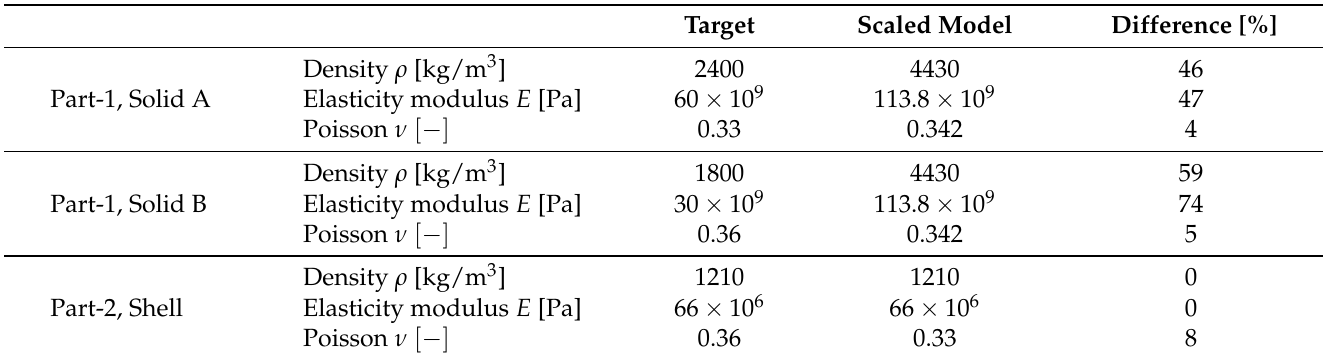
Table 5. Comparison between the material properties of the target and scaled models for Cases 5, 6, 7 and